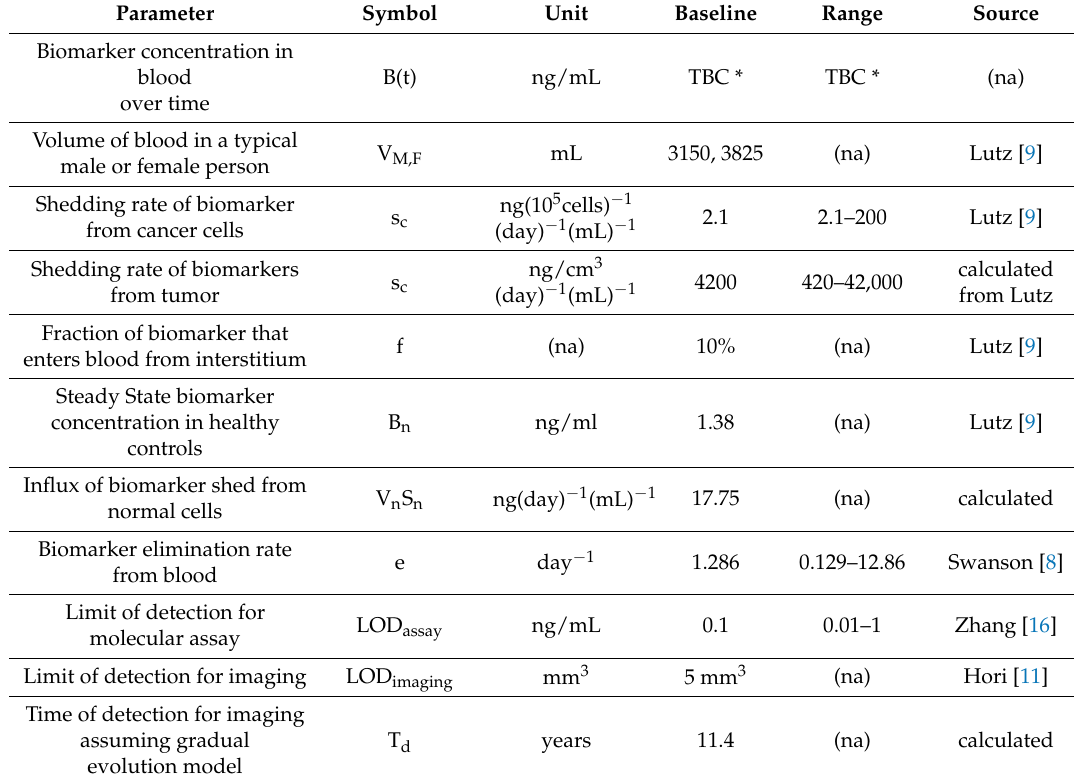
Table 2. Biomarker concentration model parameters, input value ranges, and